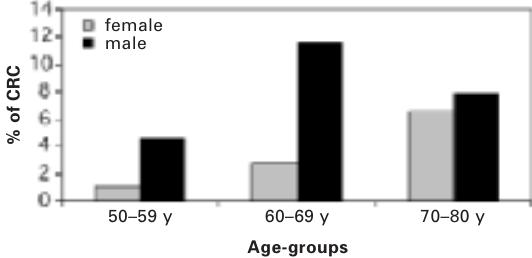
Figure 1 Distribution of cancer according to site, gender and